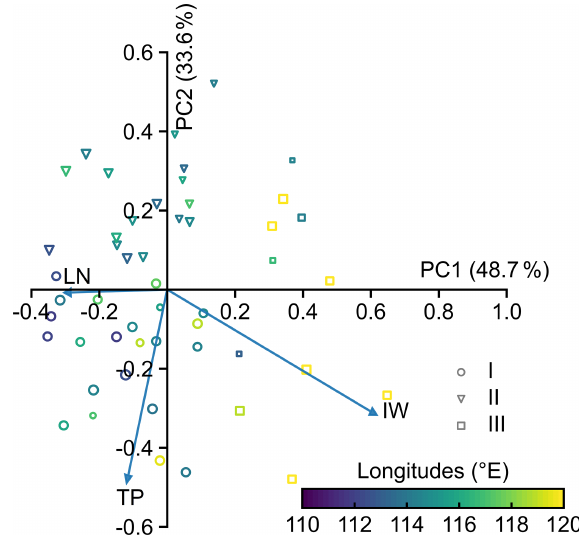
Figure 7. Loading plot of the principal component analysis (PCA) based on three nutrient-related variables. The color of scattering points represents the distributions of lakes in longitudinal order, and the directions of nutrient-related variables (i.e., LN: leached nitro- gen; TP: total phosphorus sources; IW: industrial wastewater) are annotated with blue